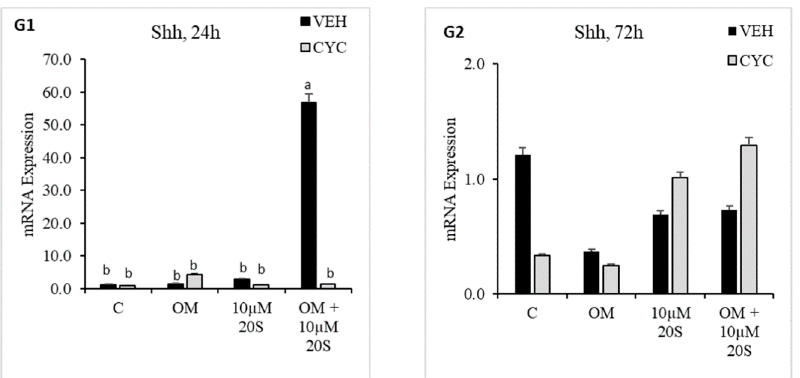
Figure 4. 20S activates osteogenic genes through the Hedgehog signaling pathway. Confluent chicken bone marrow stem cells (cBMSCs) were pretreated for 2 h with control vehicle (VEH) or 4 µM cyclopamine (CYC), followed by 24 h and 72 h of treatment with (1) control vehicle ( C ), (2) osteogenic media (OM) containing DMEM with 10% FBS, 50 µg/mL ascorbate, 0.5 µM DXA, and 10 mM β -glycerophosphate, (3) 10 µM 20S, or (4) OM + 10 µM 20S. RNA was isolated, reverse transcribed to cDNA, and qRT-PCR was conducted to analyze osteogenic gene expression. GAPDH was used as a housekeeping gene. Fold changes in gene expression relative to the control were calculated using the −ΔΔ Ct method. mRNA expression of ( A1 , A2 ) RunX2, ( B1 , B2 ) BMP2, ( C1 , C2 ) BSP, ( D1 , D2 ) BGLAP, ( E1 , E2 ) Gli-1, ( F1 , F2 ) Ptch, and ( G1 , G2 ) Shh were significantly reduced in cells treated with OM + 20S in the Cyc pretreated group compared to the VEH pretreated group. Bars represent mean ± SEM of triplicate determinations. Bars without a letter (a–b) in common are significantly different ( p < 0.05) when analyzed with Tukey’s test.